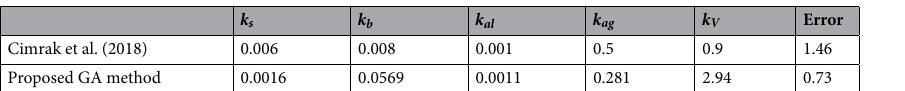
where i is the experiment number according to Table 2 and TT s , and TT e are numerical transit time and experi- mental transit time, respectively. Table 7 shows the identified values for the friction coefficients of the lung cancer cell with the radius of 6.5 μm discretized with 393 nodes using experimental results at two different flow rates (given in Table 2). Table 8 shows the entry time, transit time and the calculated errors at these two flow rates. Steps of cancer cell deformation in constriction. The model of the cancer cell deformation rigorously validated against the experimental data, presented in “Parameter identification of the spring-network model of cancer cell”, enables us to study details of the deformation process inside the constriction. The model can provide information about the deformation of cancer cells in the constriction at the length scale and time scale that are